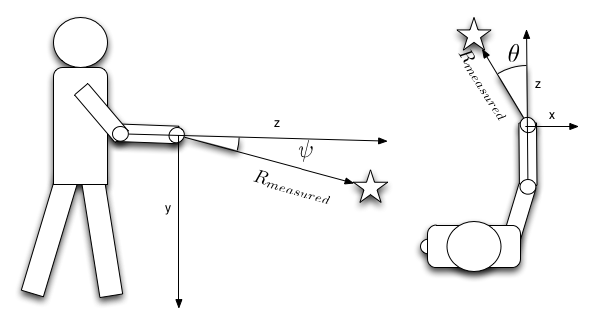
Figure 4: Vertical ( ψ ) and horizontal ( θ ) angles in spherical coor- dinates are illustrated. A potential intended target is shown as a star. The z-axis of the hand coordinate frame is defined by either the Elbow-Hand (this example) or Head-Hand ray.